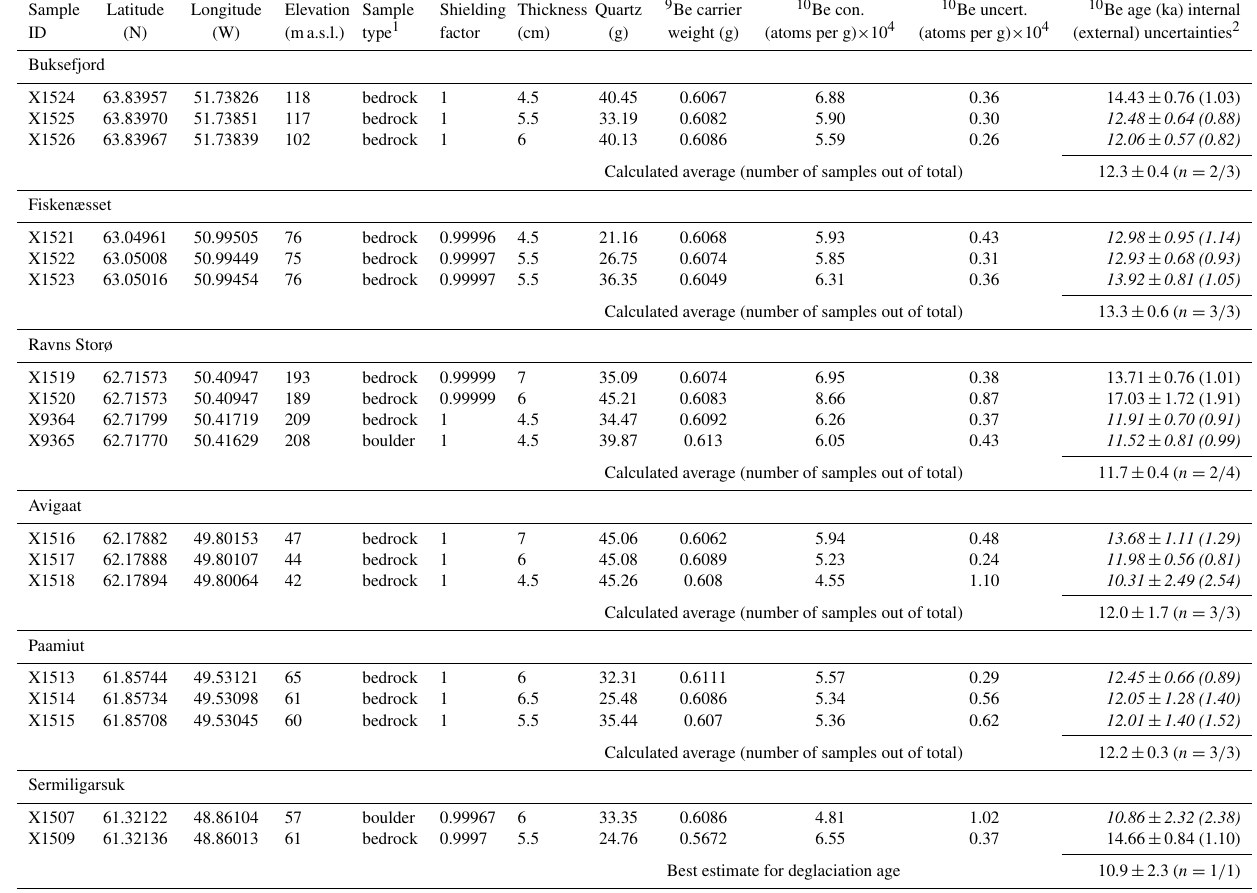
Table 1. Summary of 10 Be data from southwestern Greenland.